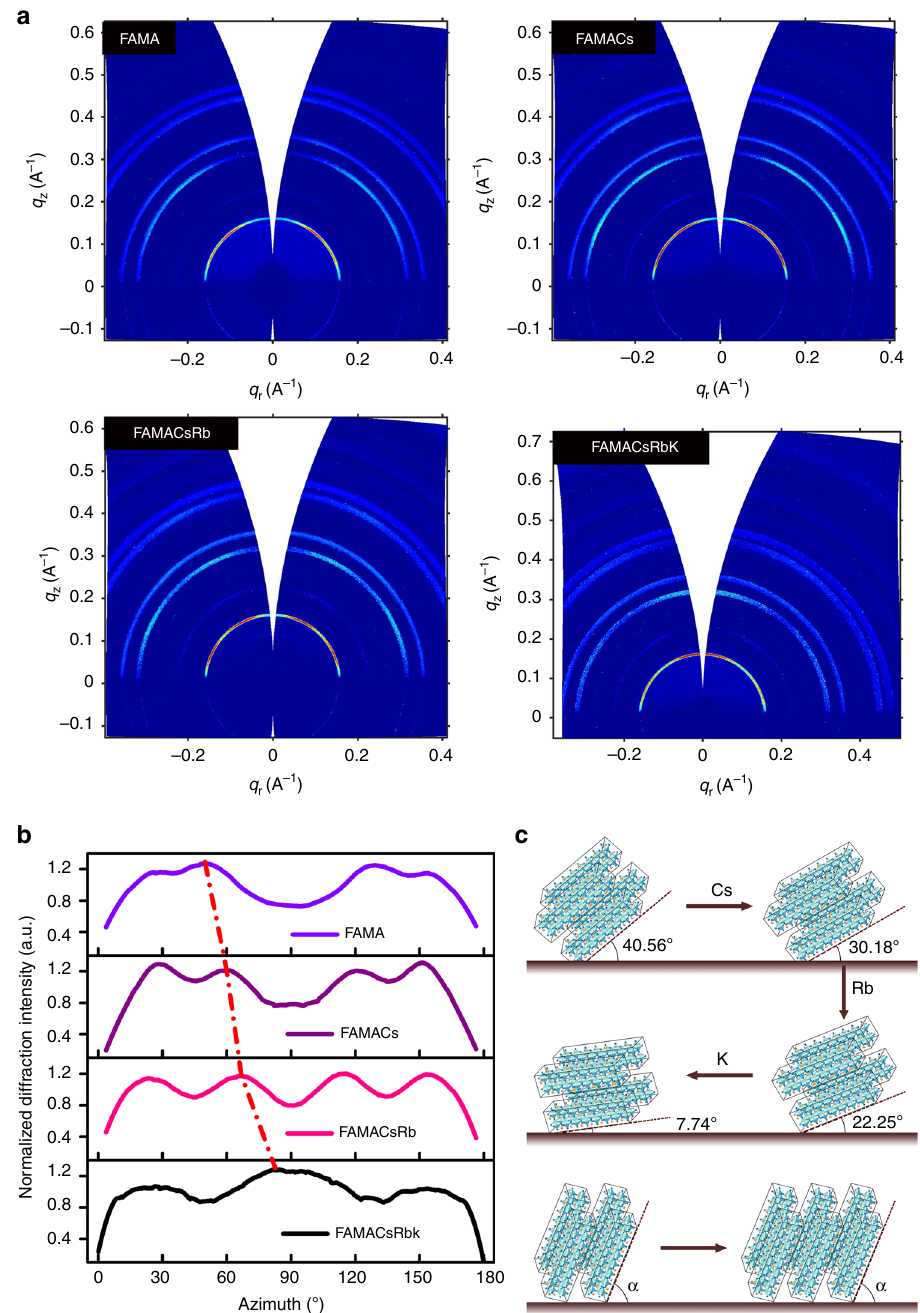
Fig. 2 GIWAXS analysis and schematic diagram for microstructure evolution process. a GIWAXS patterns for perovskite fi lms with cation cascade doping as FAMA, FAMACs, FAMACsRb, and FAMACsRbK, respectively. b Integrated intensity plots azimuthally along the ring at q r approximate to 0.16 Å − 1 , assigned to the (001) plane of corresponding perovskite fi lms noted in a . c The evolution schematic diagram of GIWAXS patterns occurred with cation cascade similar integral area of (001) peak in each sample, it indicates the series of perovskite fi lms bear the comparable crystal quality and preferable growth planes.